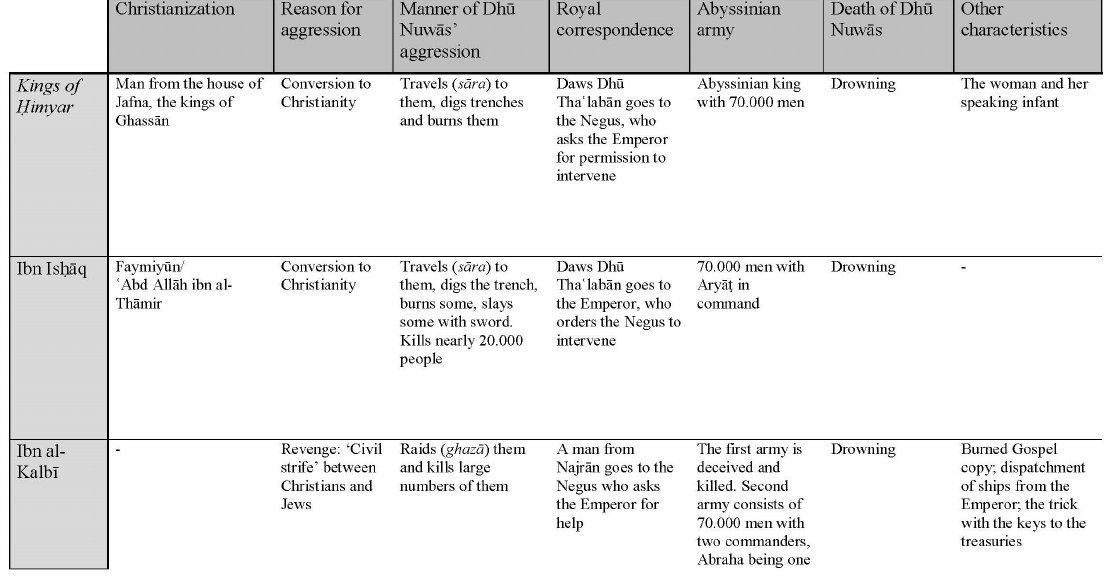
Figure 2 Table with narrative